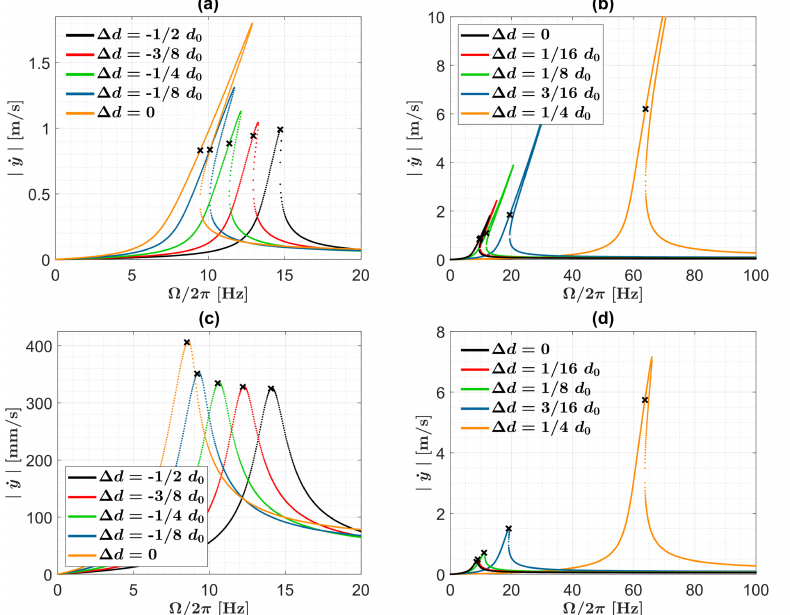
Figure 4. Relative velocity responses according to the external excitation frequencies under different harvester lengths bounded by: ( a ) − d 0 /2 (cid:54) ∆ d (cid:54) 0, R l = 1 M Ω ; ( b ) 0 (cid:54) ∆ d (cid:54) d 0 /4, R l = 1 M Ω ; ( c ) − d 0 /2 (cid:54) ∆ d (cid:54) 0, R l = 188 Ω ; and ( d ) 0 (cid:54) ∆ d (cid:54) d 0 /4, R l = 188 Ω . The excitation amplitude was defined as 4 m/s 2 and | ˙ y M | are identified with black crosses.